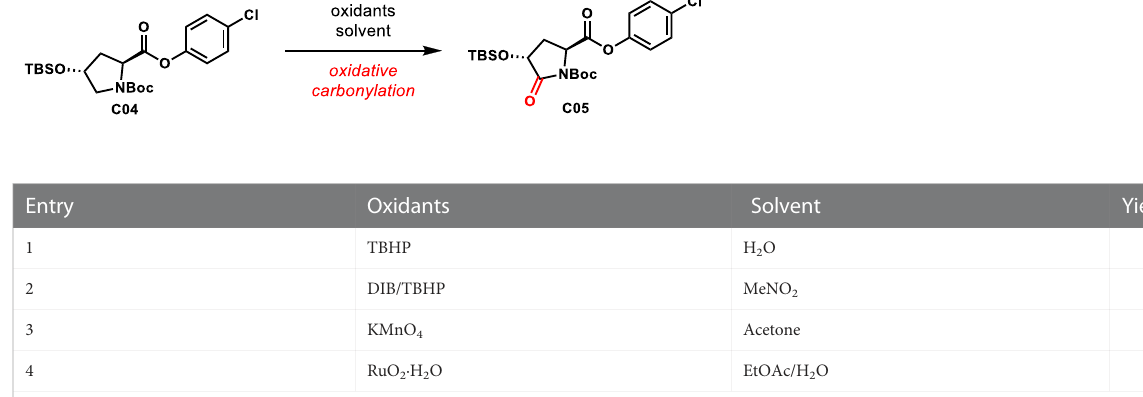
TABLE 1 Study of the oxidative